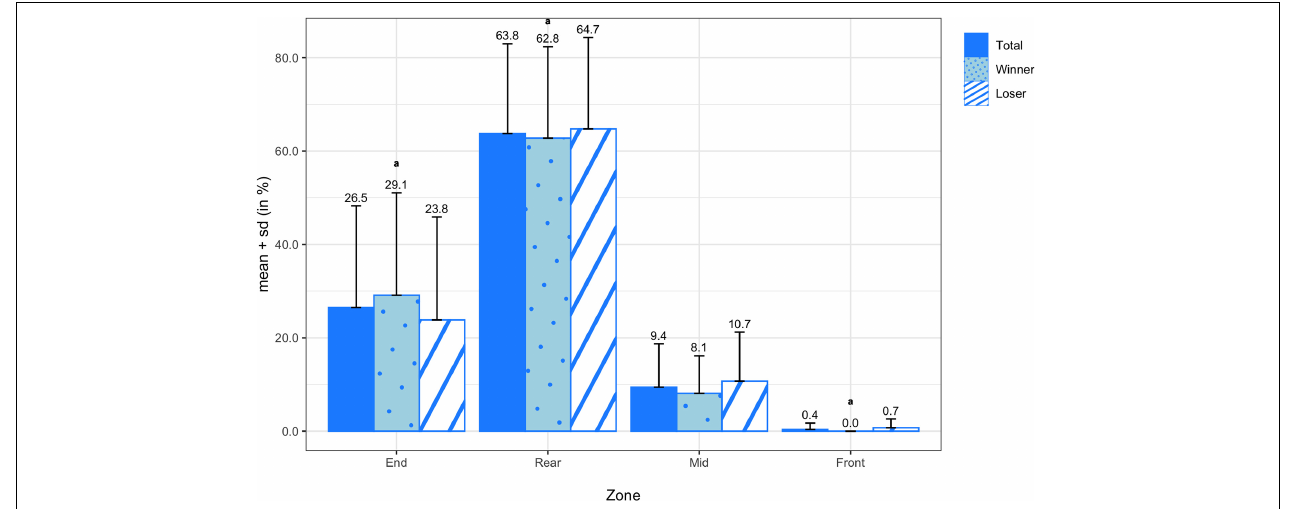
FIGURE 7 | Transition probabilities of pulls by zone for all teams, winning teams, and losing teams. Variables compared using a non-parametric test are marked with an a .